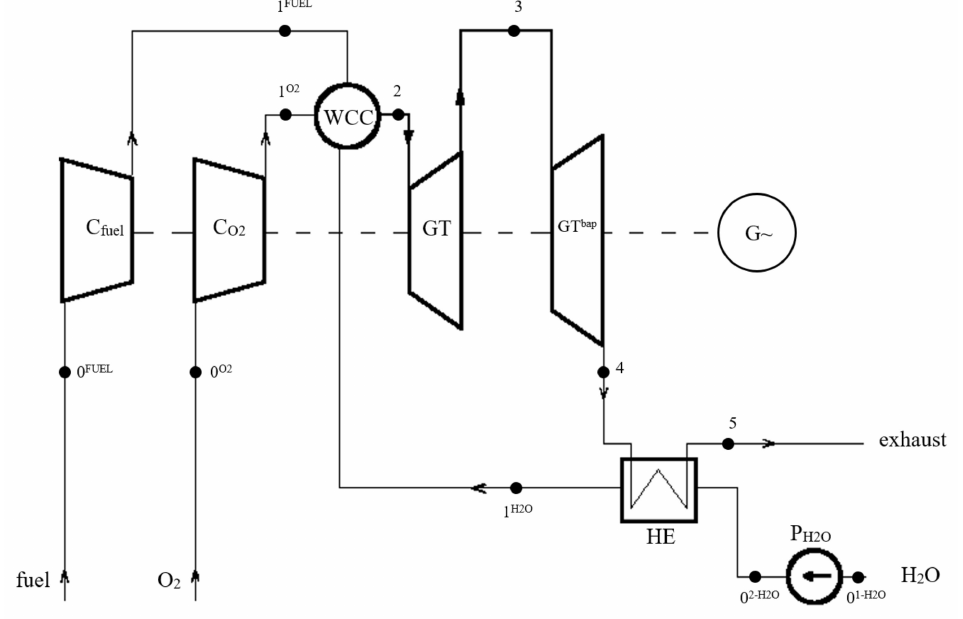
Figure 1. Process flow diagram of a gas mixture cycle PFD0—a steam-gas turbine system (0FUEL,